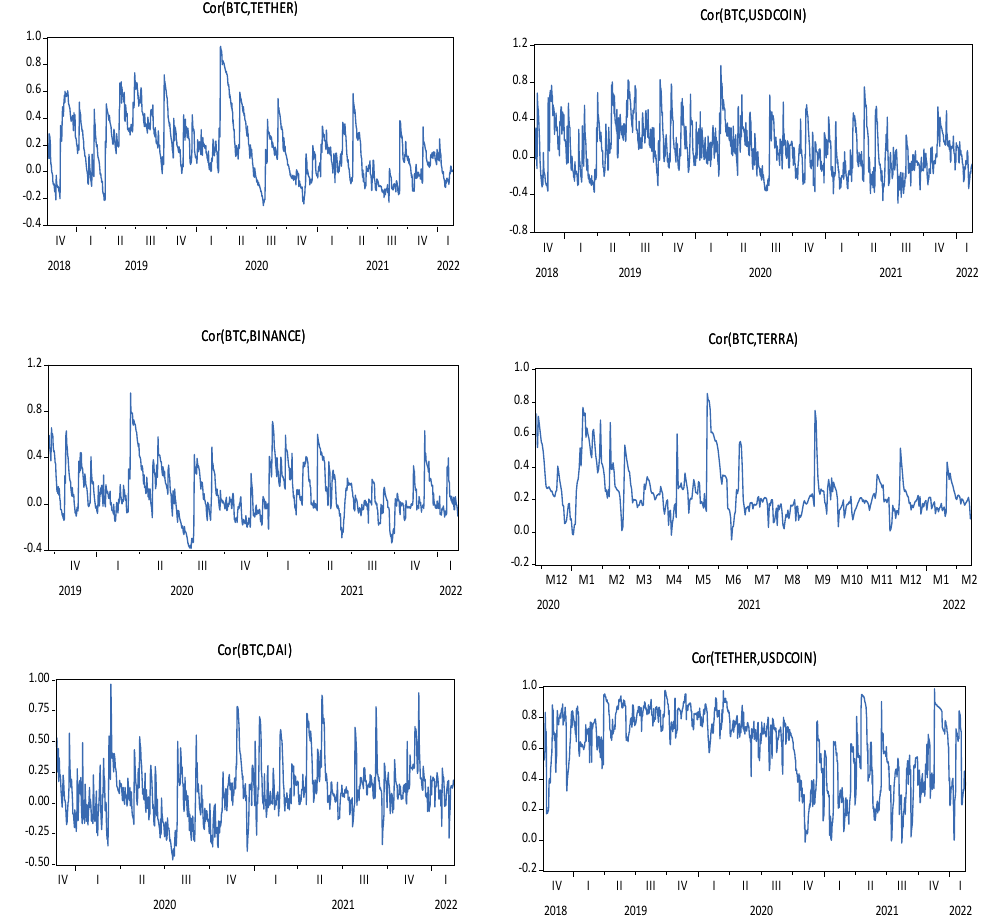
Figure 2. Conditional correlations between the Bitcoin and stablecoins markets (VAR-BEEK-GARCH model). Notes: Bitcoin–stablecoins correlation via the VAR–BEKK–GARCH model.